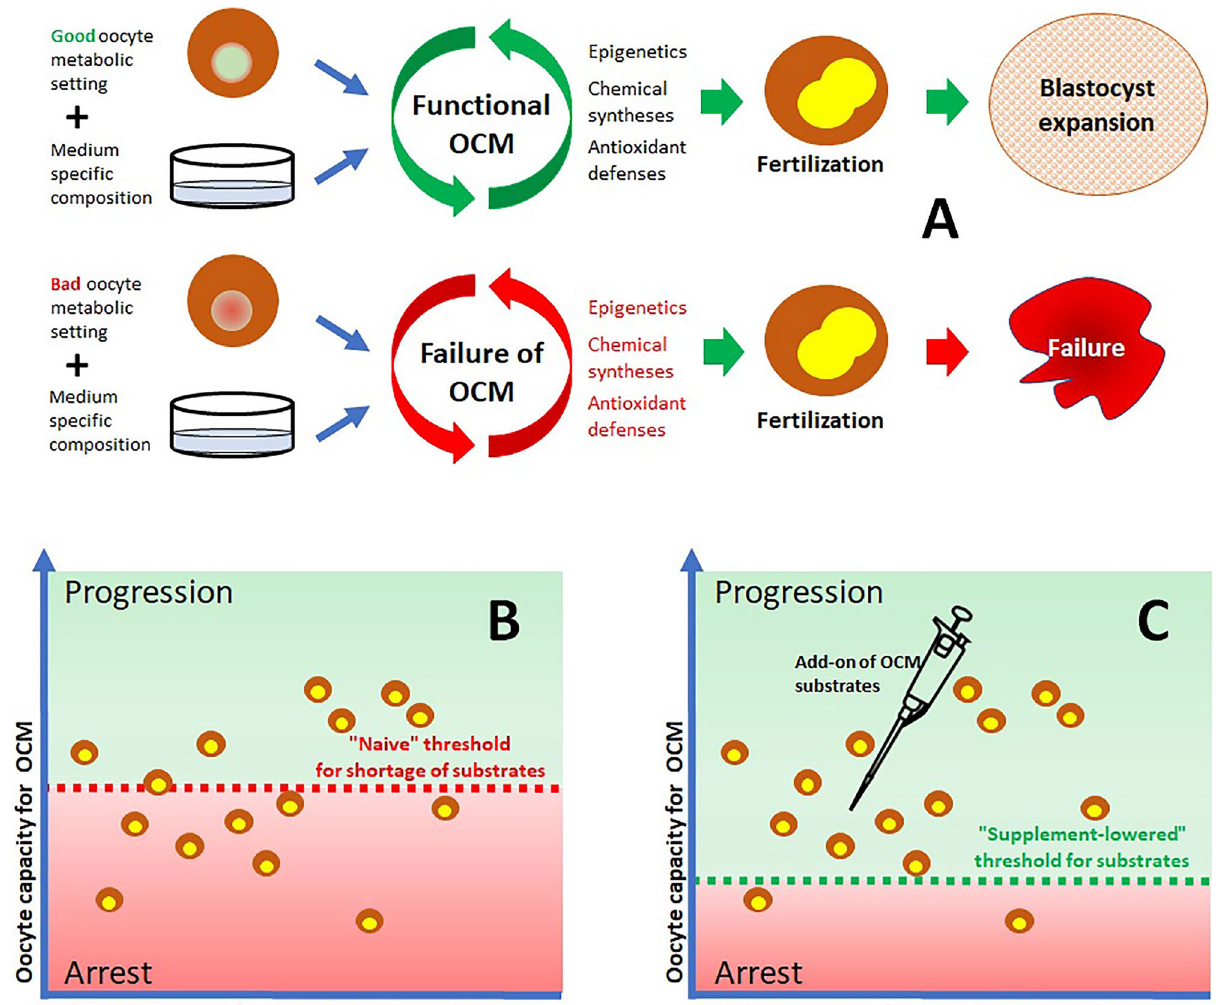
Figure 8. The one carbon metabolism (OCM) checkpoint. ( A ) Each maturing oocyte has its own, genetically determined, capacity to process the OCM substrates. In in vitro conditions the variety and amounts of substrates available to run the OCM is the one provided by the culture medium, and it may not fit with the need of some oocytes. Oocytes well-fitting with their medium will achieve maturation, fertilization and, thereafter, blastocyst expansion. Oocytes with a bad fit with the medium will suffer a deficit of function of the OCM and, although able to mature and to get fertilized, will fail the full development to blastocyst. ( B ) Out of a cohort of oocytes undergoing IVC, some of them will have good ability to process OCM substrates, other will need larger amounts. The specific threshold of different oocytes is reported by their position with respect to the vertical axis. Any oocyte positioned above the available concentration of substrates (dotted line, green background area) will be able to run the OCM and to progress. All those below the dotted line (red background area) are predicted to fail to expand to blastocyst after fertilization. ( C ) The maturing environment (culture medium or in vivo) of the same cohort of oocytes has been supplemented with due amounts of the OCM substrates. Even if the intrinsic metabolic capacity of the oocytes remains the same, the supplementation of OCM substrates lifts-up their concentration, which allows more of oocytes to fall within the progression area and to expand to blastocyst once